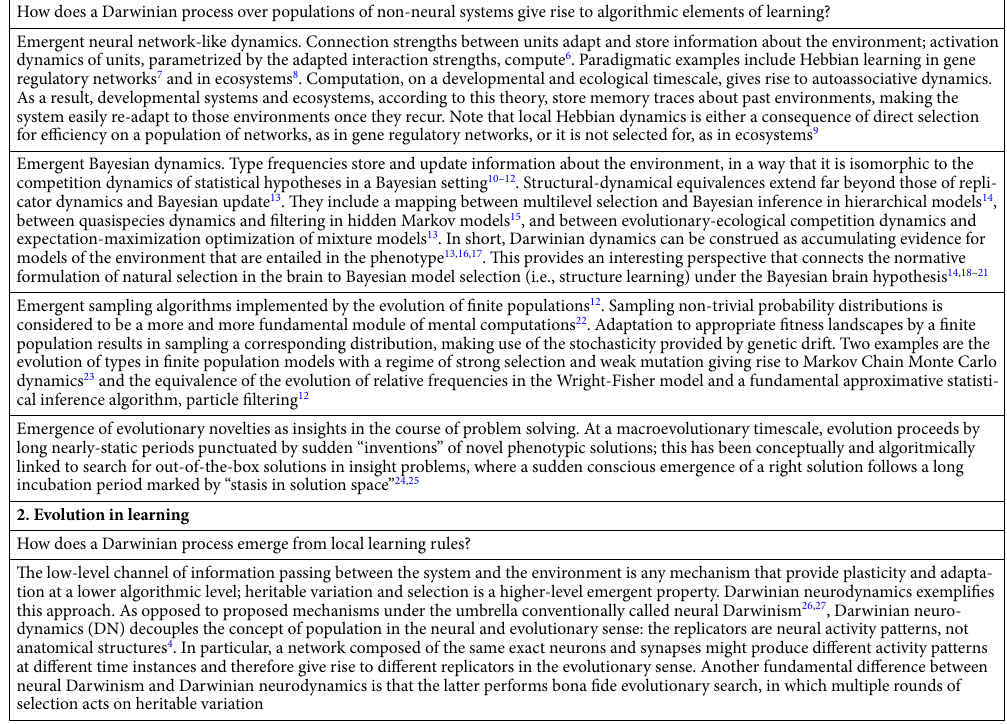
Table 1. A unified view of evolutionary and learning processes, as part of a theory of high-dimensional